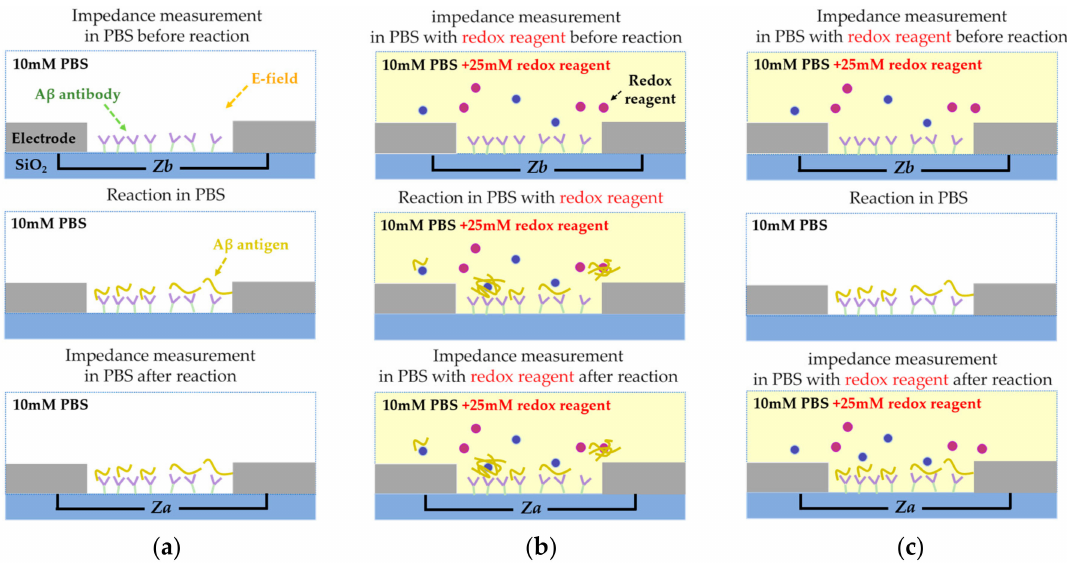
Figure 5. Illustration of experimental processes for ( a ) non-faradaic EIS (nf-EIS), ( b ) f-EIS, and ( c ) the proposed